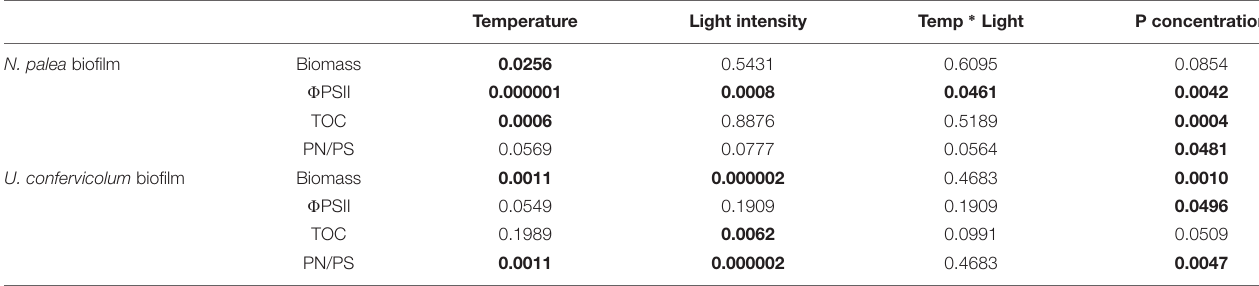
TABLE 1 | P -values for two-way and one-way ANOVAS to test the effect of environmental conditions on the biomass (DW), maximum quantum yield ( (cid:56) PSII), EPS quantity (TOC), and EPS quality (PN/PS) of the biofilms before the